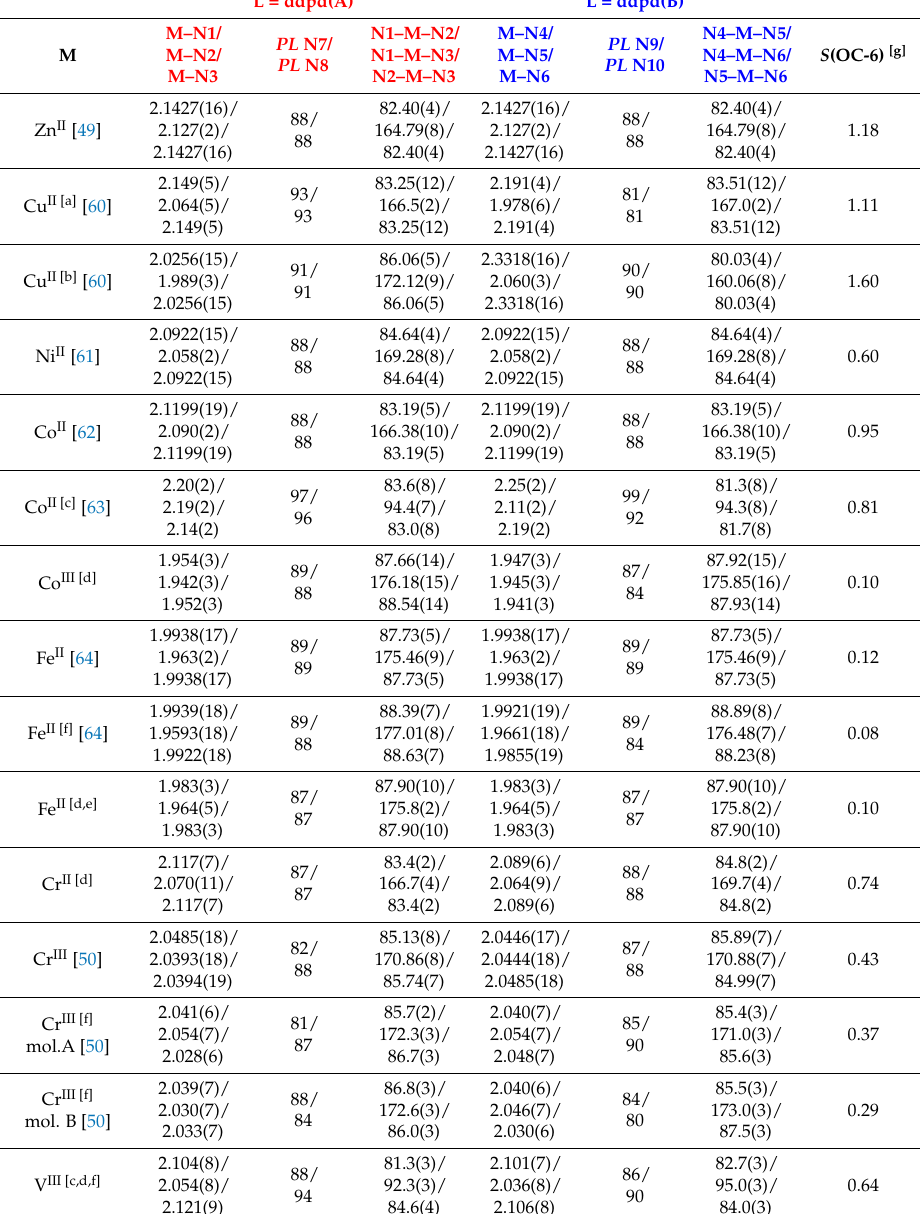
Table 1. Relevant metrical data of [M(ddpd) 2 ] n + ions in the solid state; mer isomers if not indicated otherwise; [BF 4 ] − salts if not indicated otherwise; distances in Å, PL in % and angles in ◦ . Red and blue color code indicates the different ddpd ligands (see Scheme